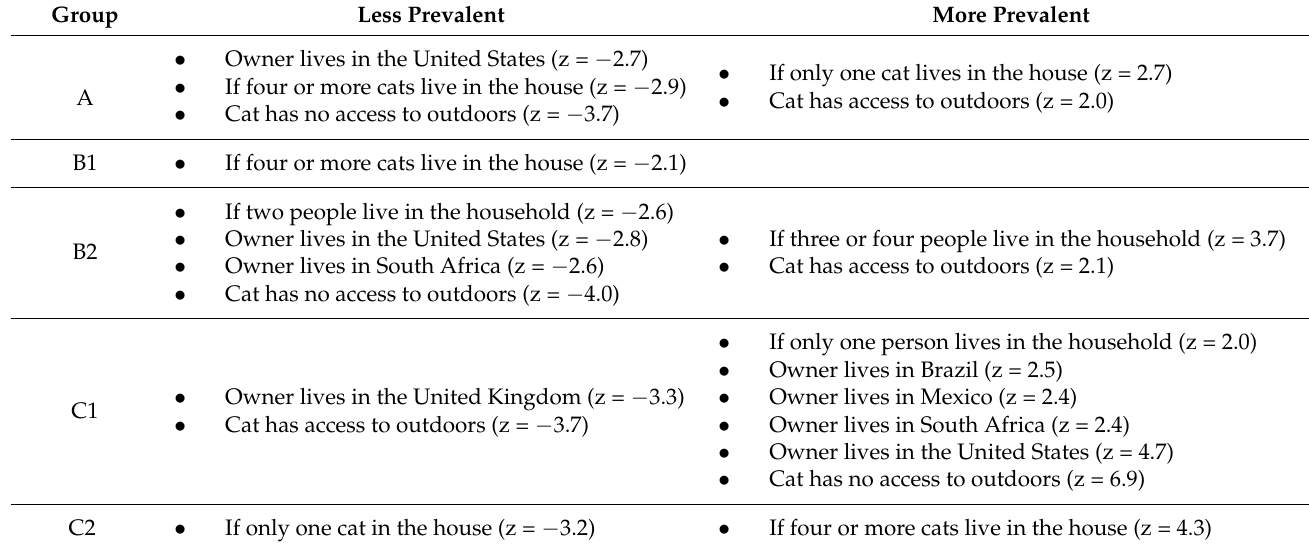
Table 4. Demographic features, less and more prevalent in the different groups (z = standardized residuals). Group Less Prevalent More